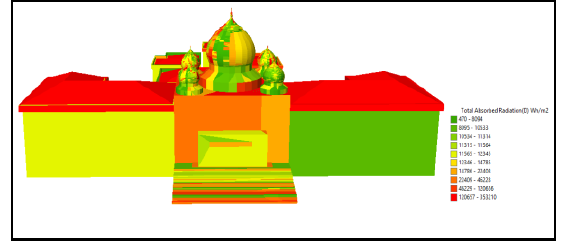
Figure 13. The simulation of heat absorb in original position igure shows the heat absorbed in after the angle being changed b 37.5 . The minimum heat absorbed by the building is 3276 W/m² and the maximum heat absorbed is 352910 W/m². The mean of heat absorbed are 49075 W/m².